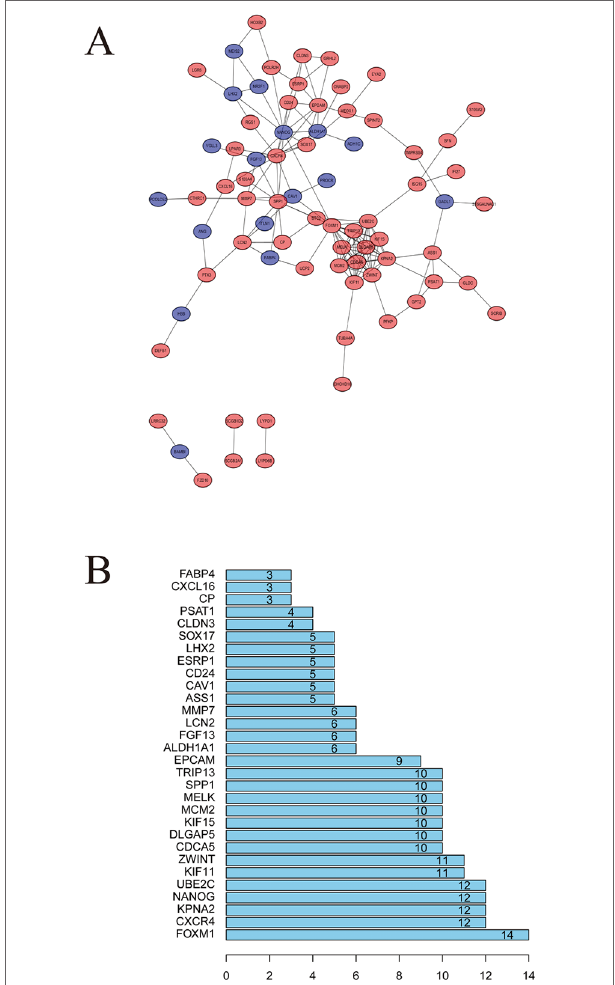
( Table 1 ). Three-dimensional structure of the top 4 candidate molecule drugs was found in Pubchem database and shown in Figures 4A–D .